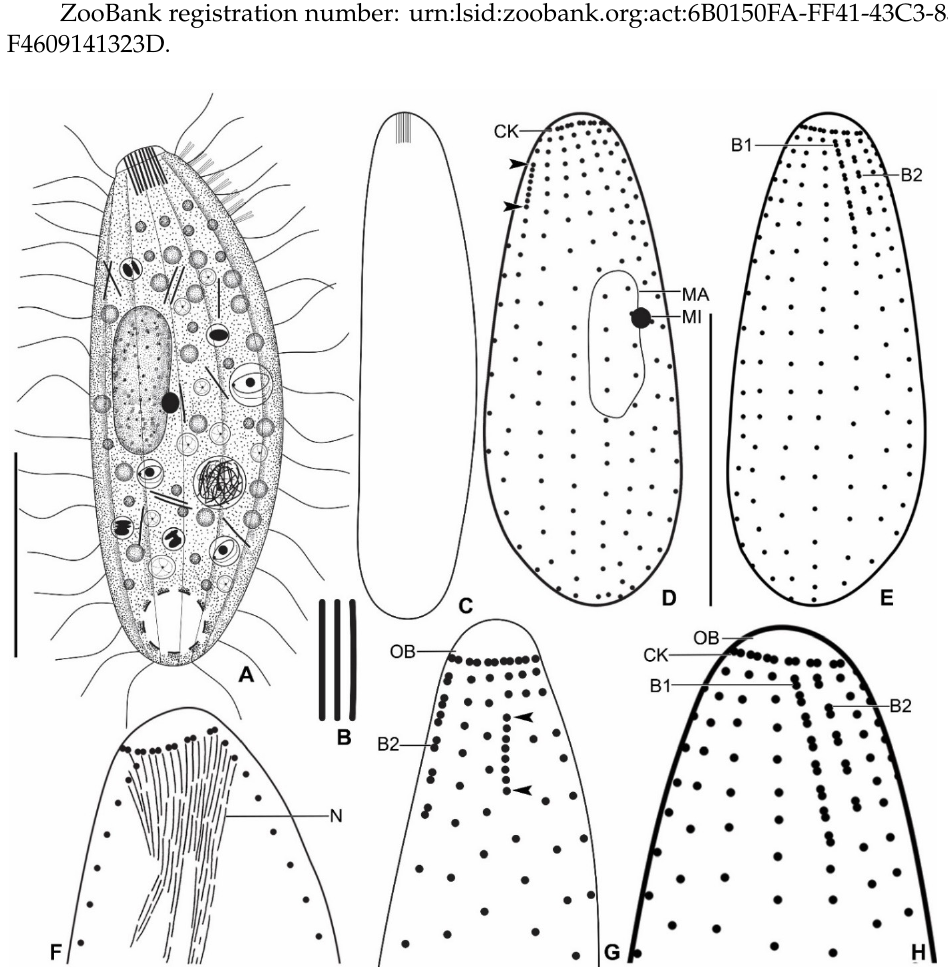
Figure 1. Fuscheriides baugilensis sp. nov. from life ( A – C ) and after protargol impregnation ( D – H ). ( A ). A representative specimen showing the body shape, the rod-shaped extrusomes and the ellipsoidal macronucleus. ( B ). Extrusomes in vivo. ( C ). Outline of slenderly ellipsoid, starved specimen. ( D , E , G , H ). Ventral ( D ), dorsal ( E , H ), and right lateral ( G ) view of the holotype ( D , E , H ) and a paratype ( G ) specimen, showing the somatic ciliary rows, the dikinetidal circumoral kinety, the two dorsal brush rows, and the subapical condensation (arrowheads). ( F ). The nematodesmata originate from the circumoral dikinetids and the anterior somatic kinetids. CK, circumoral kinety; B1–2, dorsal brush rows; MA, macronucleus; MI, micronuclei; N, nematodesmata; OB, oral bulge. Scale bars: 20 µ